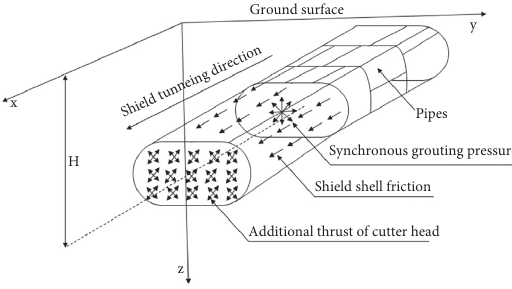
Figure 3: Analysis model of shield tunnel